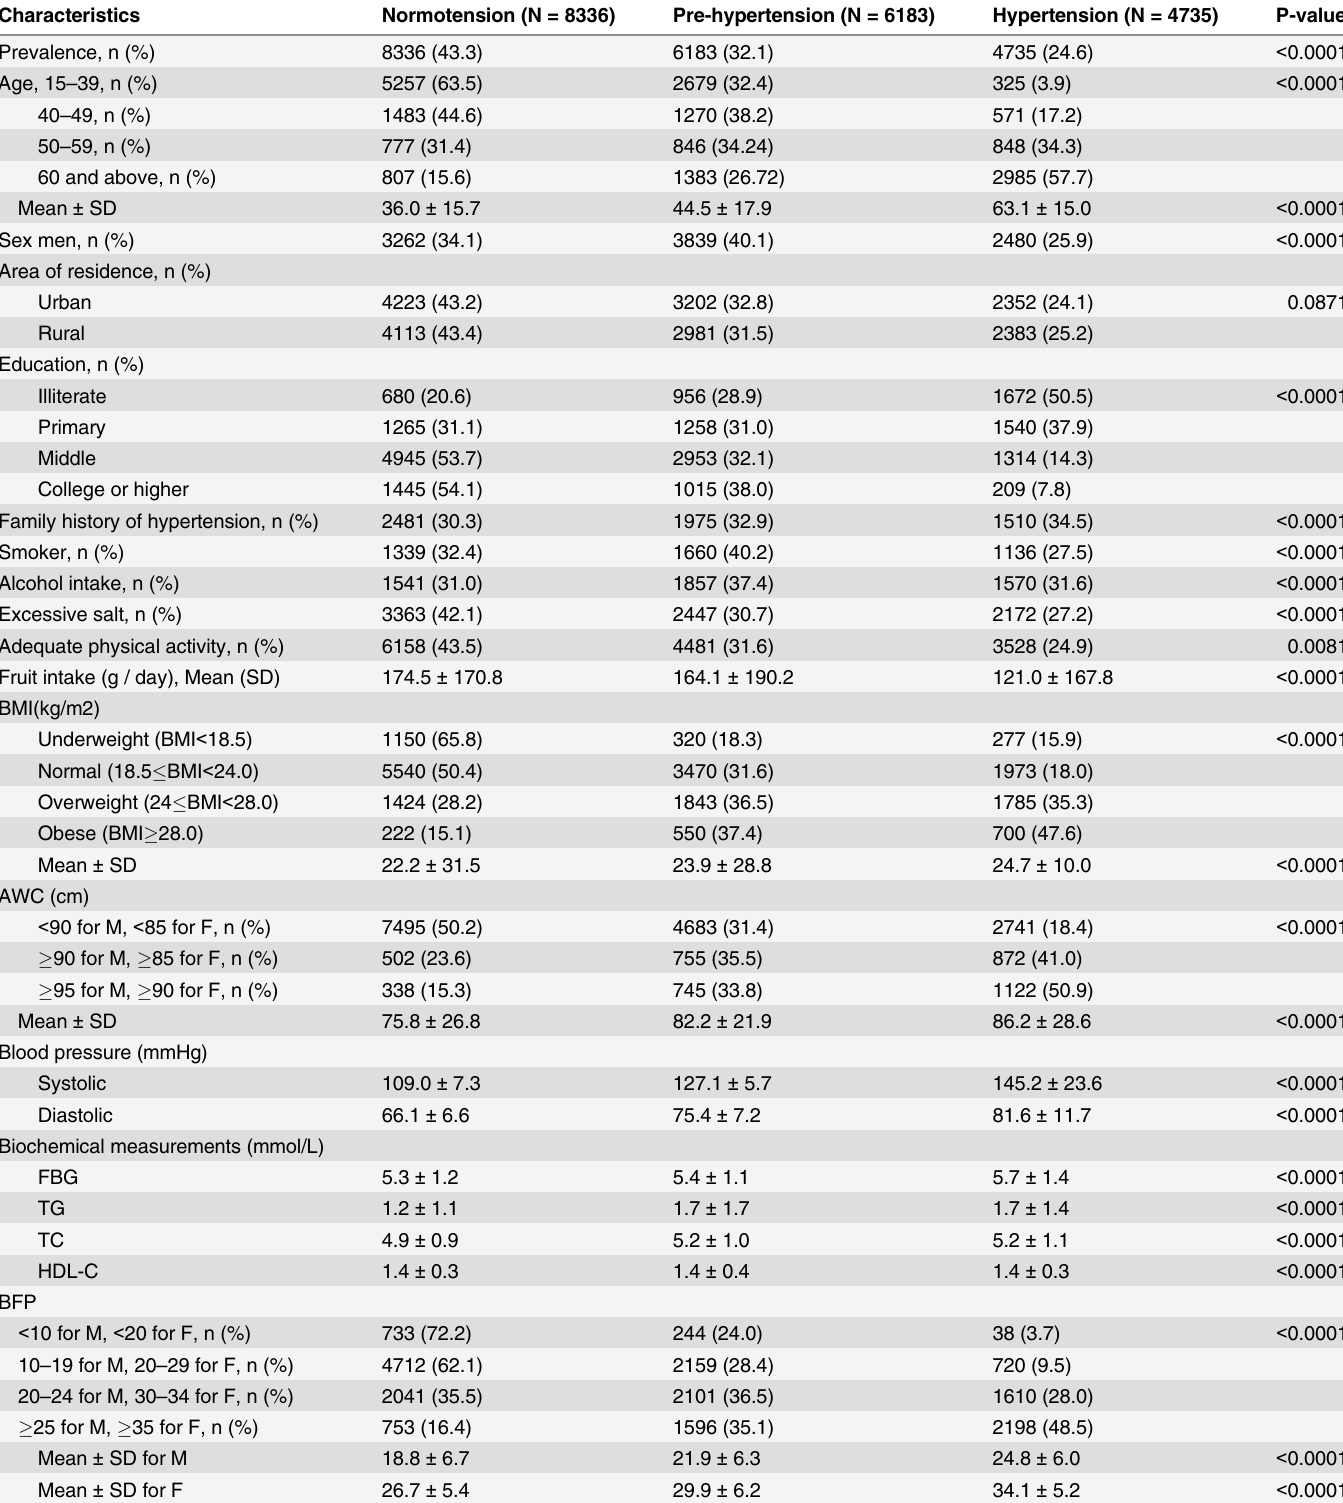
Table 1. Distribution of hypertension by socio demographic and lifestyle factors among the adults of Southern China in 2013 (n =